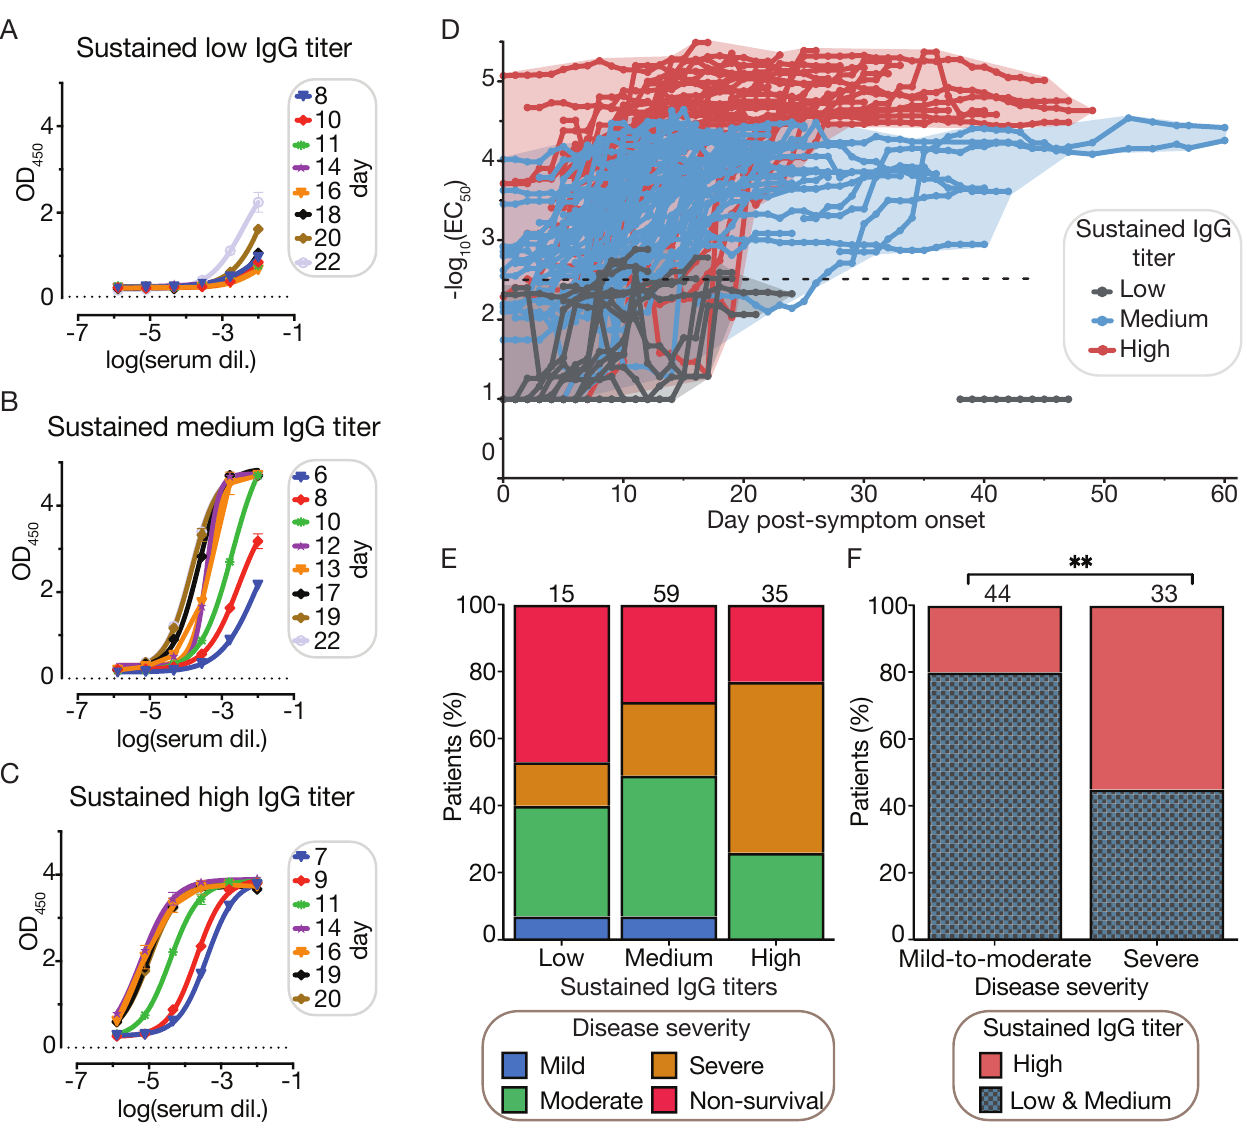
Fig 2. Sustained IgG titers are associated with severity of disease. (A-C) SARS-CoV-2 spike IgG ELISA titration of plasma samples over the course of hospitalization for representative patients showing three distinct evolutions of IgG titers. ELISA experiments were carried out as two experimental replicates, each consisting of two technical replicates. (A) Representative patient with a sustained low IgG titer during hospitalization. (B) Representative patient with a sustained medium IgG titer during hospitalization. (C) Representative patient with a sustained high IgG titer during hospitalization. (D) EC 50 titers over time were used to categorize patients with � 7 days of hospitalization (n = 130) into three categories that describe the sustained IgG titer: i) low (grey), medium (blue) and high (red). Categorized patients are required to show daily IgG EC 50 titers for at least for 5 consecutive days within the range delimited by the 25 th and 75 th EC 50 percentiles (sustained low IgG: -log 10 (EC 50 ) � 25 th perc; sustained medium IgG: 25 th perc > -log 10 (EC 50 ) � 75 th perc; and sustained high IgG: -log 10 (EC 50 ) > 75 th perc; see materials and methods and S1 Fig). (A-D) We define “day post-symptom onset" (PSO) as the day relative to the patient-reported onset of symptoms. (E) Mosaic plot describing the distribution of severity of COVID-19 relative to the sustained IgG titer class. (F) Distribution of sustained IgG titers relative to the severity of disease among survivors (77 patients), patients with mild and moderate disease were merged into a single category (Chi- square, �� p <